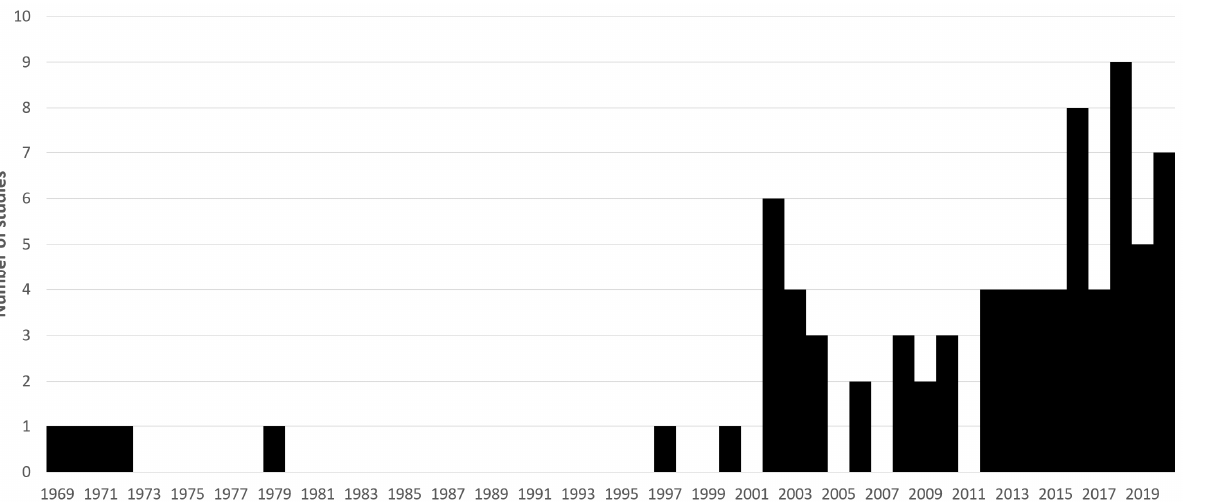
Figure 1. A histogram of eligible papers found in the primary pubmed search according to their year of publication.